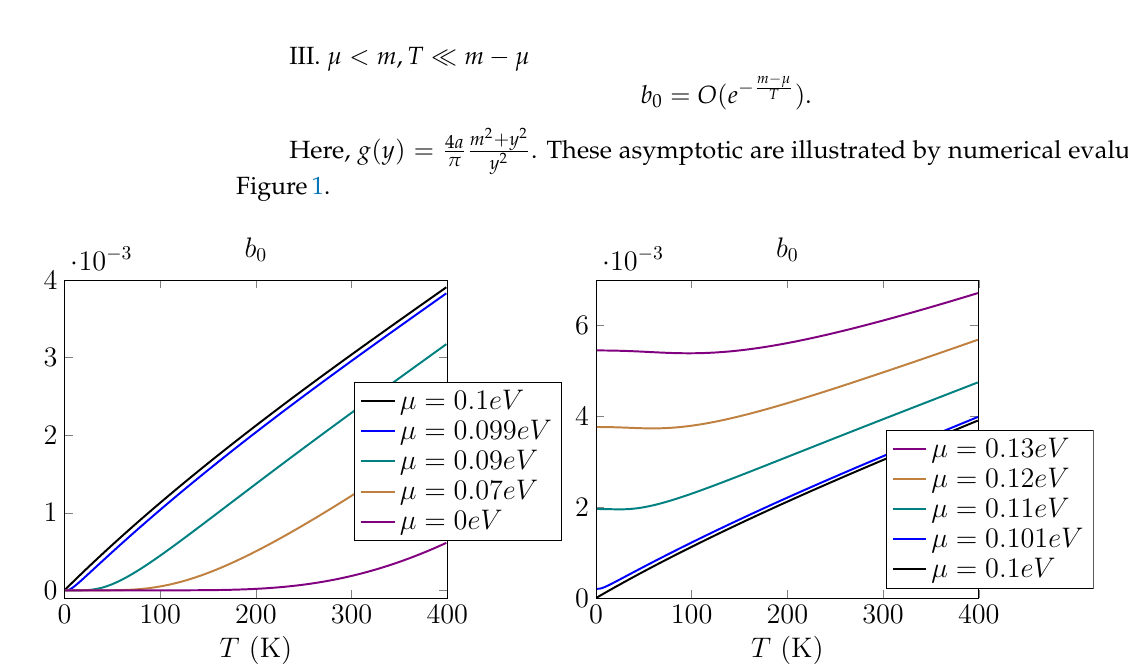
Figure 1. The functions b 0 for a = 100 nm, m = 0.1 eV, and different values of chemical potential µ . For µ < m , the function b 0 0 for low temperatures; for µ = m , it is linear, and, for µ > m , it starts from constant values in agreement with ∼ Equation